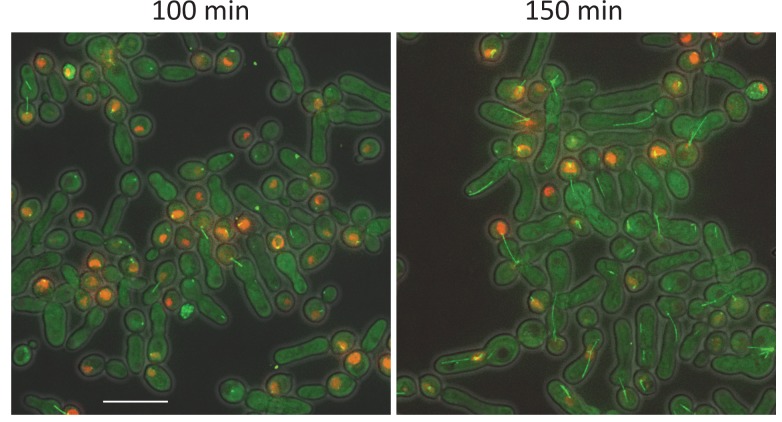
Phenotype of O. polymorpha cdc28-as cells.Logarithmically growing cdc28-as GFP-TUB1 (HPH1210) cells in YPDS medium were treated wtih 5 µM IAA for the indicated time. Inhibition of Cdc28 kinase caused elongated bud morphologies as observed in S. cerevisiae. However, cells were not arrested completely and appearance of short spindle and segregated nuclei at 150 timepoint indicate cell cycle progression, albeit slowly.